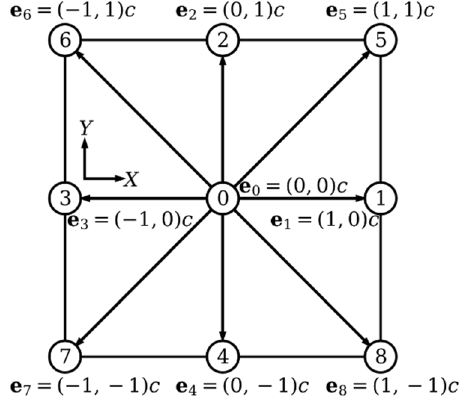
Figure 1. D2Q9 Cartesian lattice and discrete velocities.